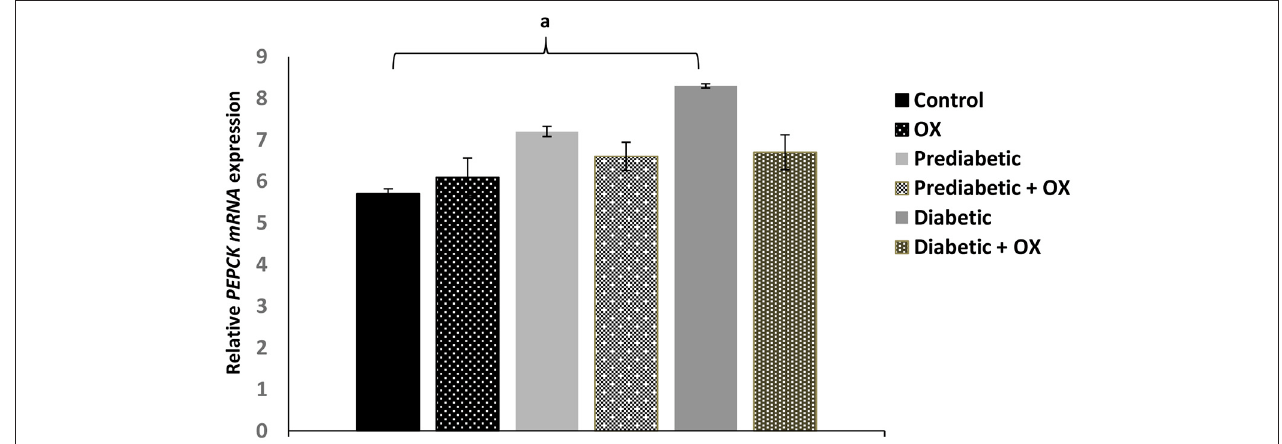
FIGURE 4 | Effect of oxytocin medication on hepatic PEPCK enzyme activity (mean ± SEM) in different groups of Wistar rats. PEPCK , phosphoenolpyruvate caboxykinase , OX, oxytocin. a P ≤